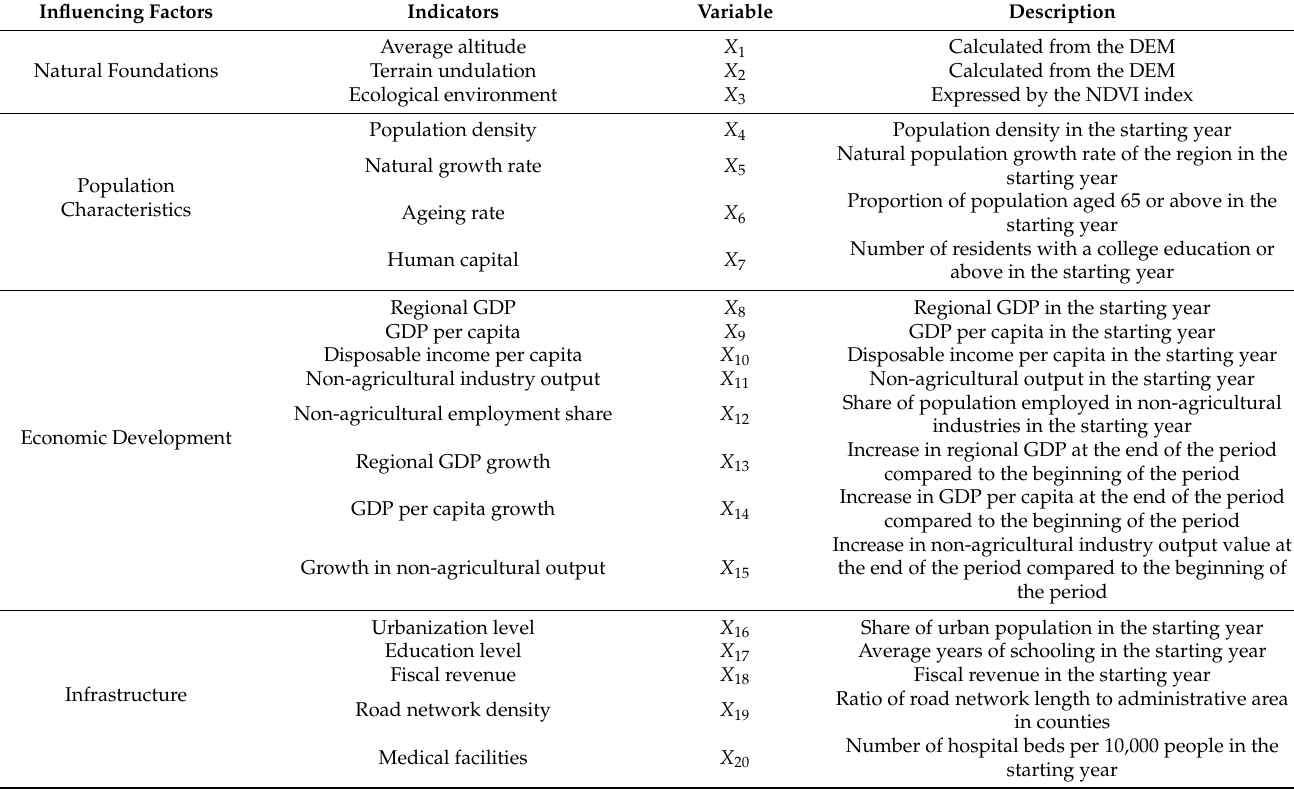
Table 4. Selection and description of influencing factors of county population